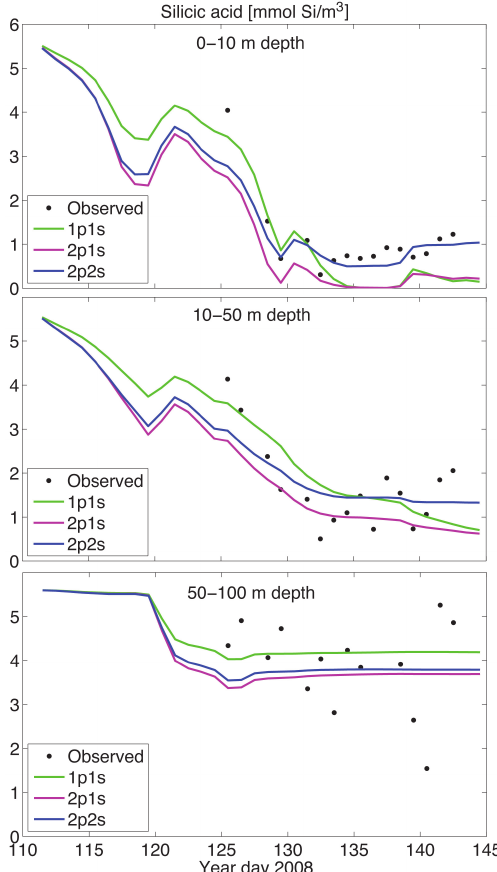
Fig. 8. Observed and simulated mean silicate concentrations for different depth intervals.